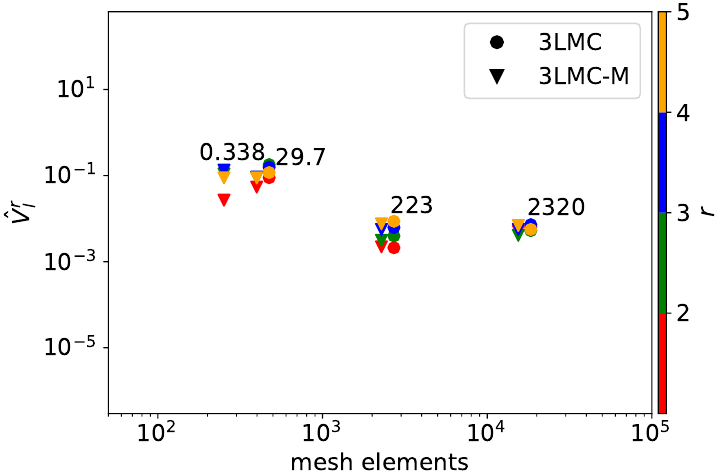
Figure 6. Variances of moments across levels for 3LMC (circle) and 3LMC-M (triangle). For legibility, the values are slightly shifted on the x-axis. The leftmost triangles correspond to the meta-level values. The numbers added represent C l [ sec ] of 3LMC-M.